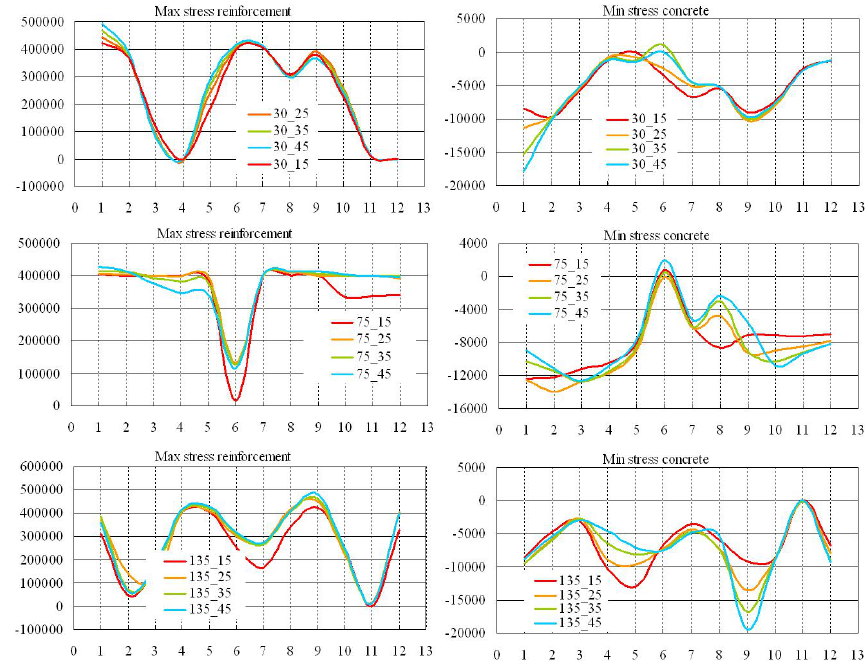
Fig. 6. Example of building stresses (in kPa) computed in the frame sections, for different loading magnitudes and fixed inclination angles: